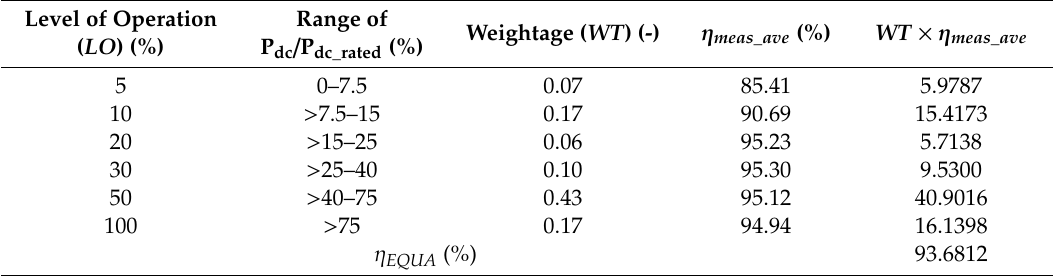
Table 7. Weighted e ffi ciency for the K4200TL inverter when G = Gi and T = 25 ◦ C with individual weightage.